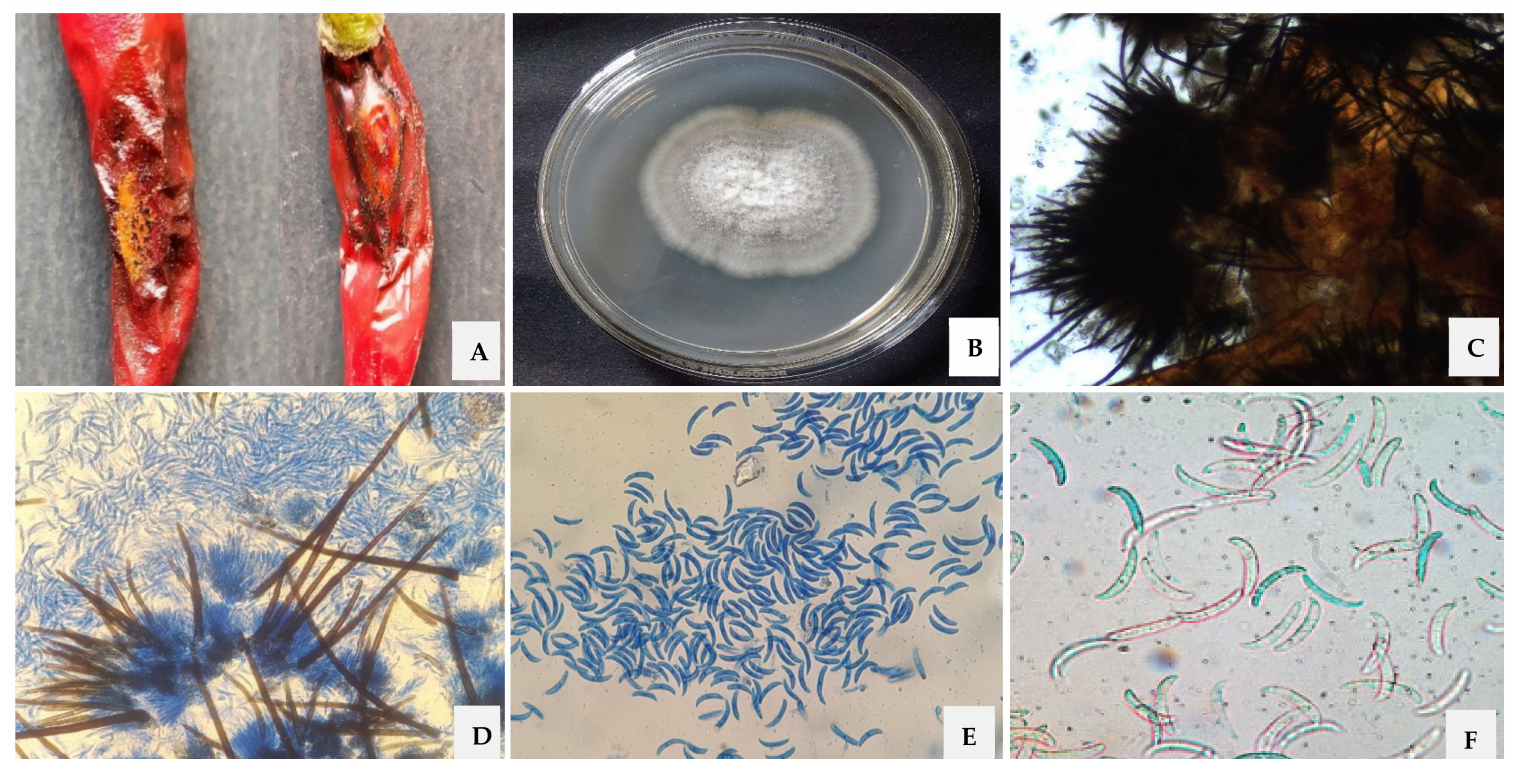
Figure 1. ( A ) Chilli fruit associated with anthracnose disease. ( B ) Pure colony C. truncatum after 5 days on PDA medium. ( C ) Acervuli on chilli fruit. ( D ) Conidia on conidiophore and setae. ( E ) Conidia of C. truncatum at 10 × . ( F ) Sickle-shaped conidia of C. truncatum at 40 ×